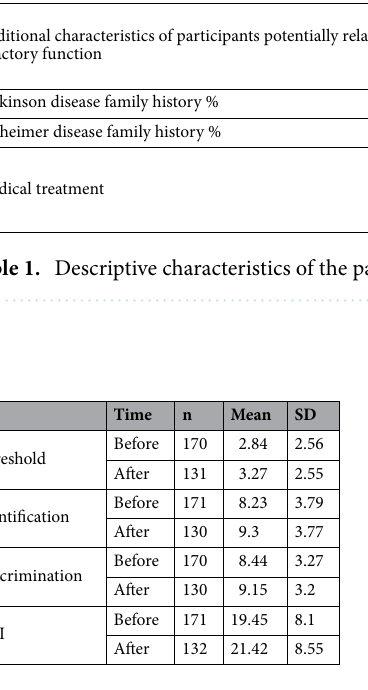
Table 2. Results of Sniffin’ Sticks testing conducted during the first (before) and the second (after) visit to the